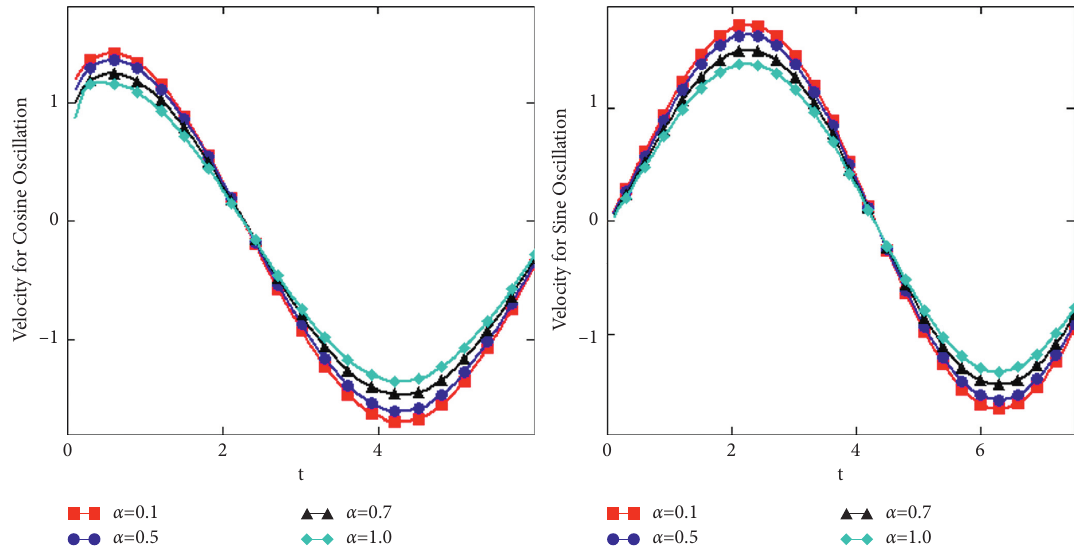
Figure 2: The variation of α for both the oscillations with ω � π /4, λ � 0 . 8, λ